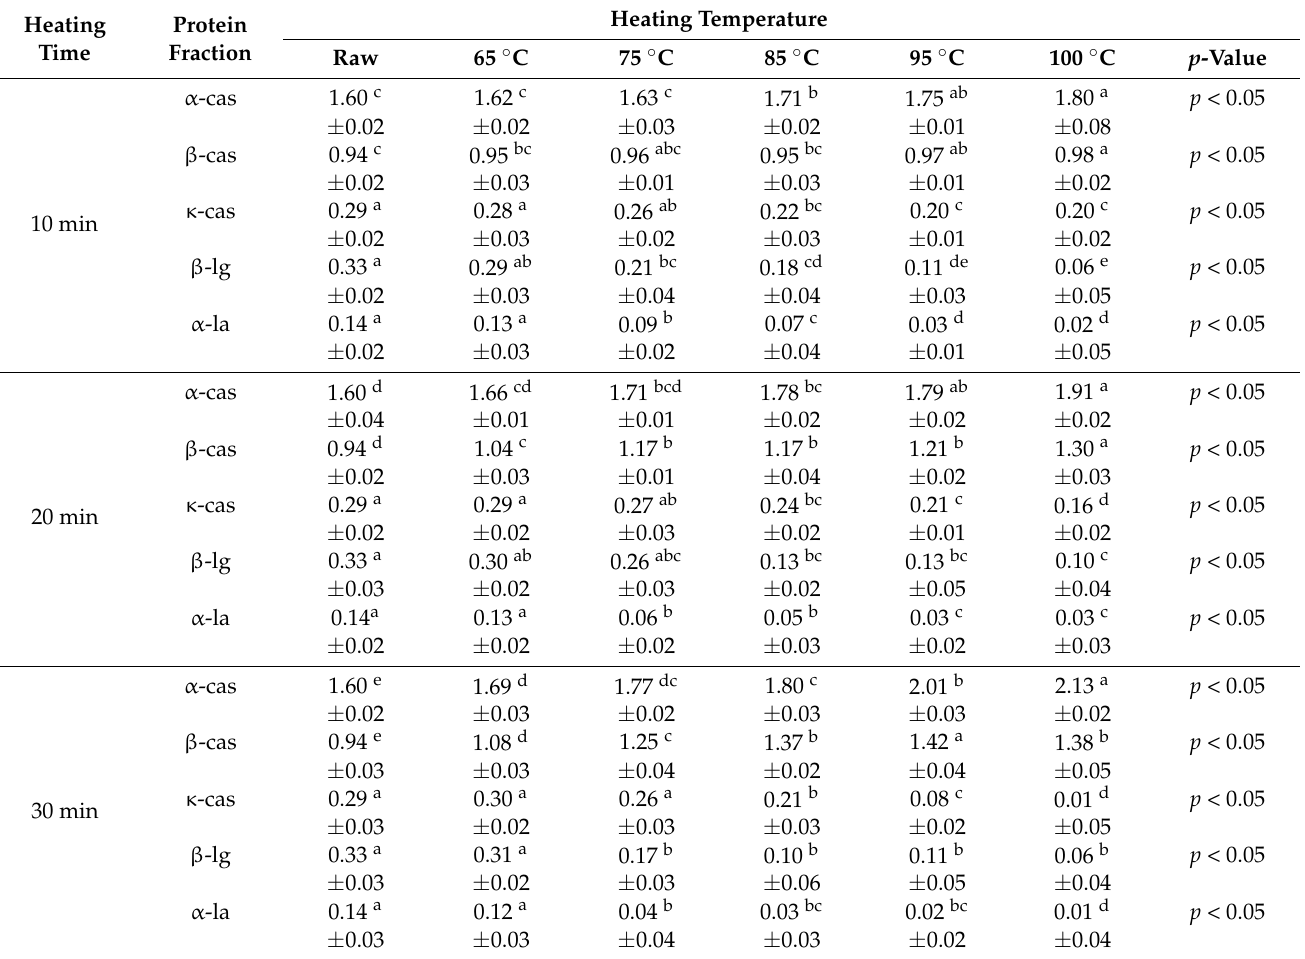
Table 1. Effect of heating time and temperature on the content of protein fractions (g/100 mL ± SD).